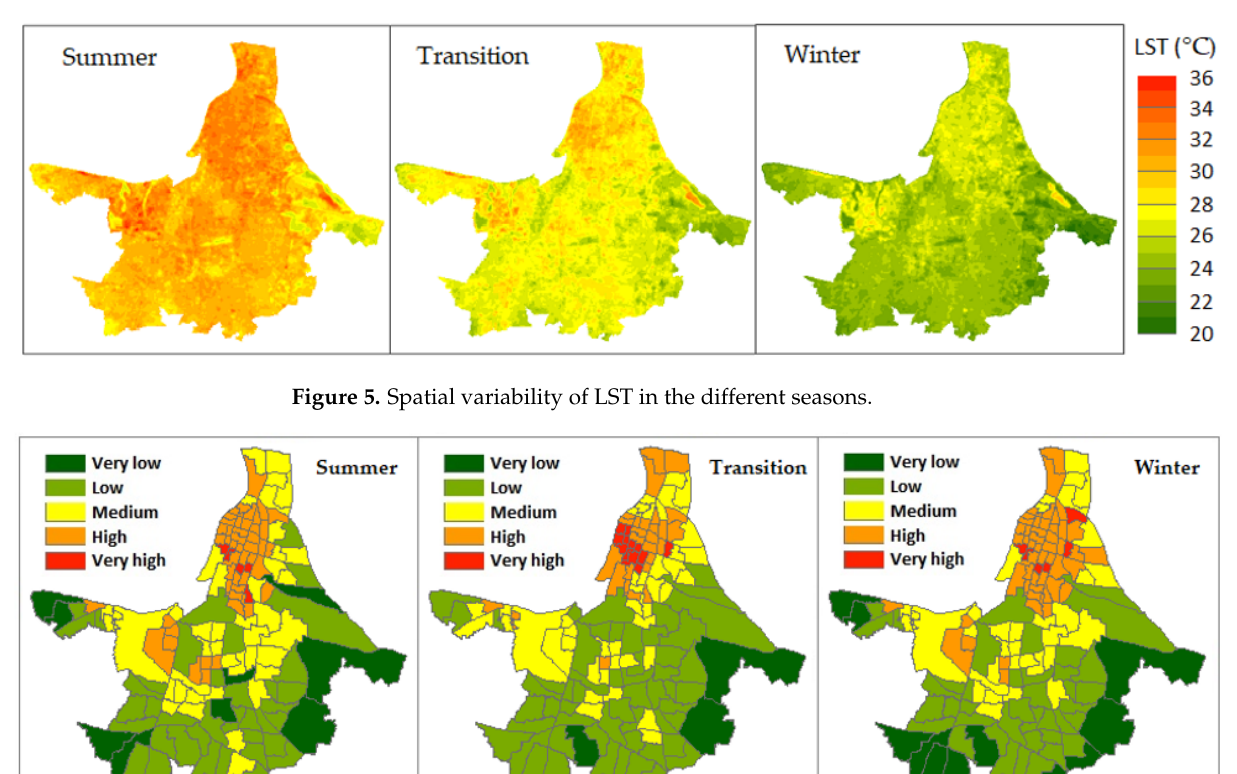
Figure 4. LST in the different LULC types. Boxplots contain information of minimum, maximum, interquartile range, and average value of the data. AL—Artificial land, BL—Bare land, VL—vegetation land, GL—Grassland, CL—Cropland, WB—bodies of water. ( A ) Summer season, ( B ) Transition season, ( C ) Winter season.